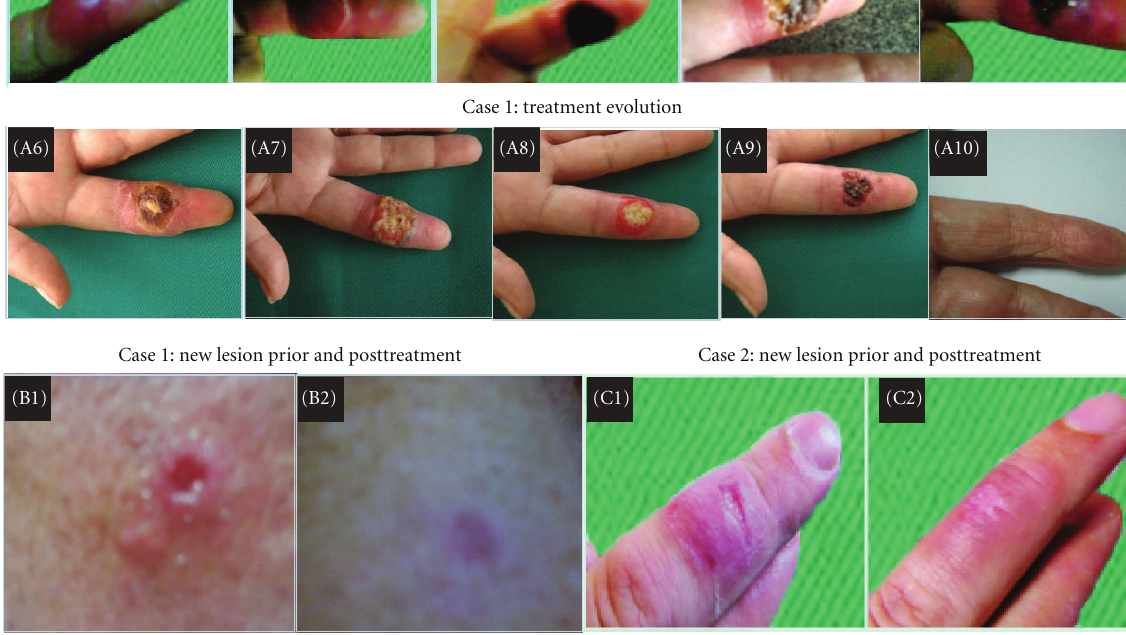
Figure 1: (A1): papule on 2nd left finger. (A2)–(A5): four months evolution prior to treatment. (A6)–(A10): lesion healing. (B1): reoccurrence, new lesion detection thirty days post treatment. (B2): healed lesion. (C1): lesion on 3rd right finger. (C2): healed